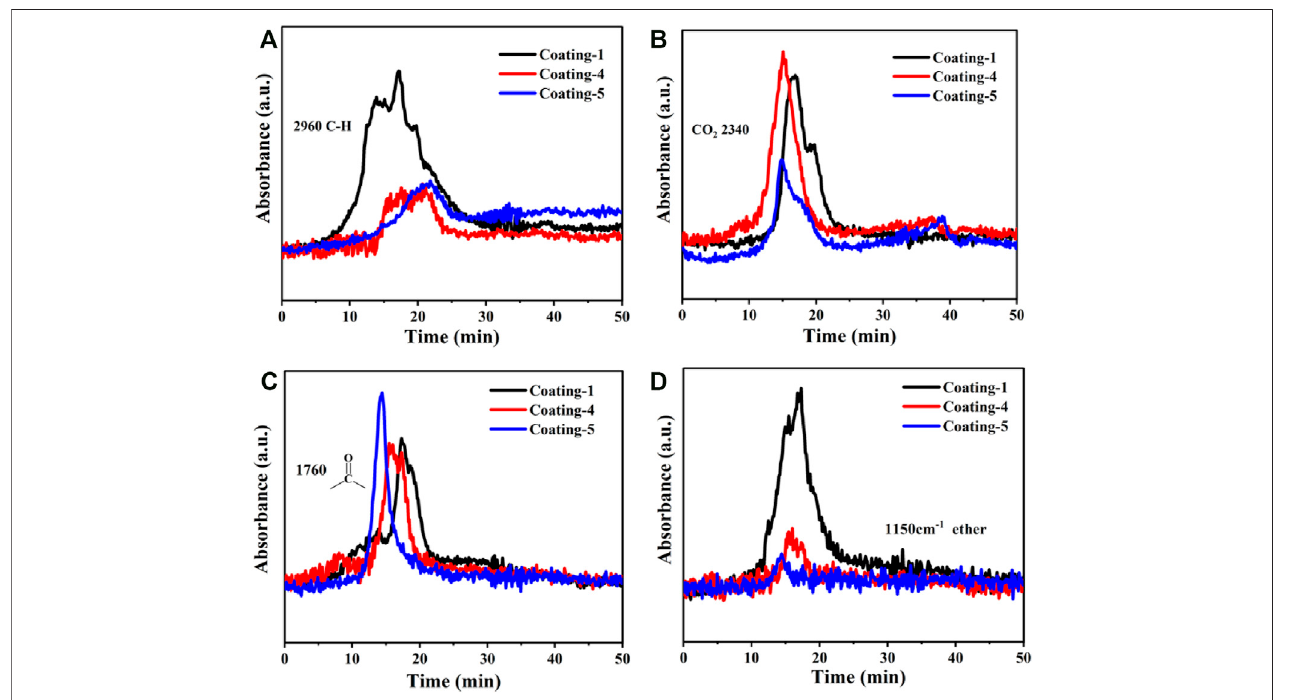
FIGURE 13 | TG-FTIR results of coating-1, 4 and 5. (A) C-H, (B) CO 2 , (C) -C=O-, (D)